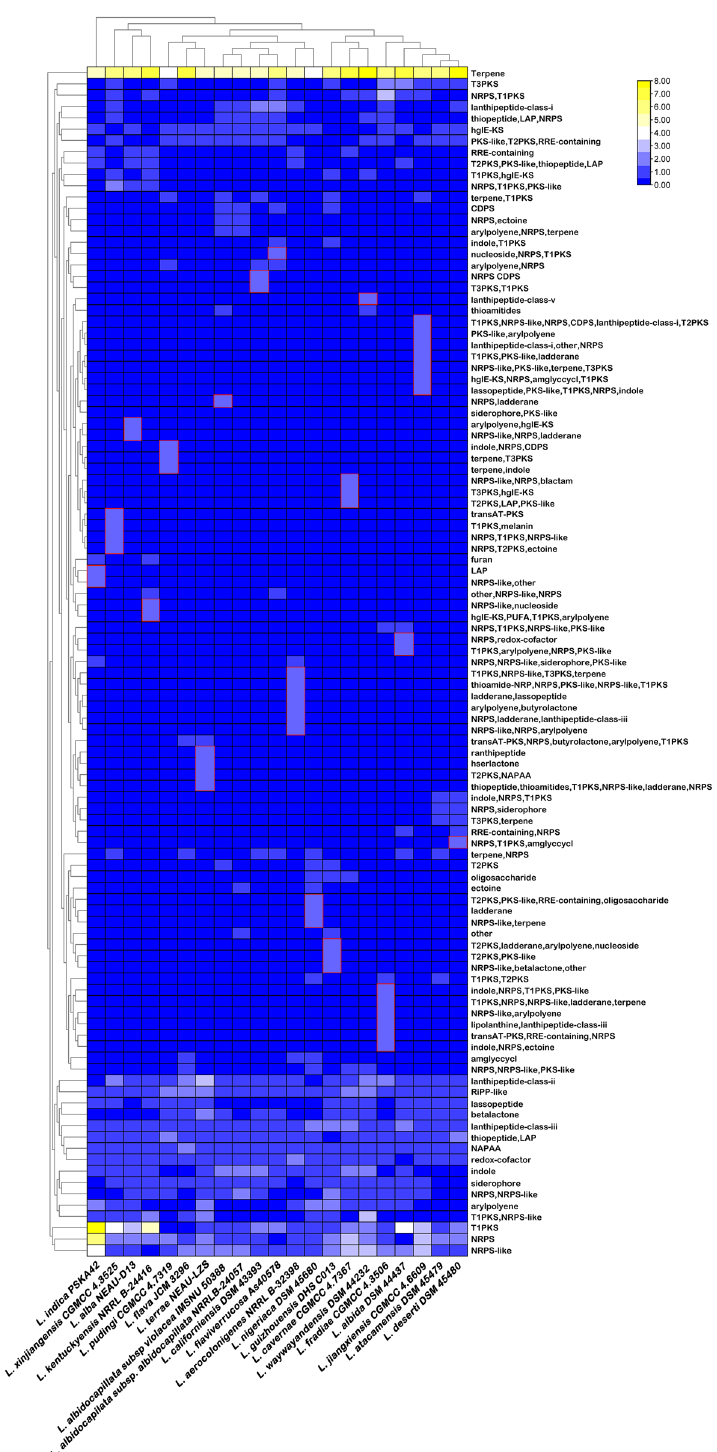
Figure 5. Heat map showing the abundance of BGCs distributed in Lentzea genome as predicted by antiSMASH database. Color keys represent variation of copy numbers of individual cluster among Lentzea